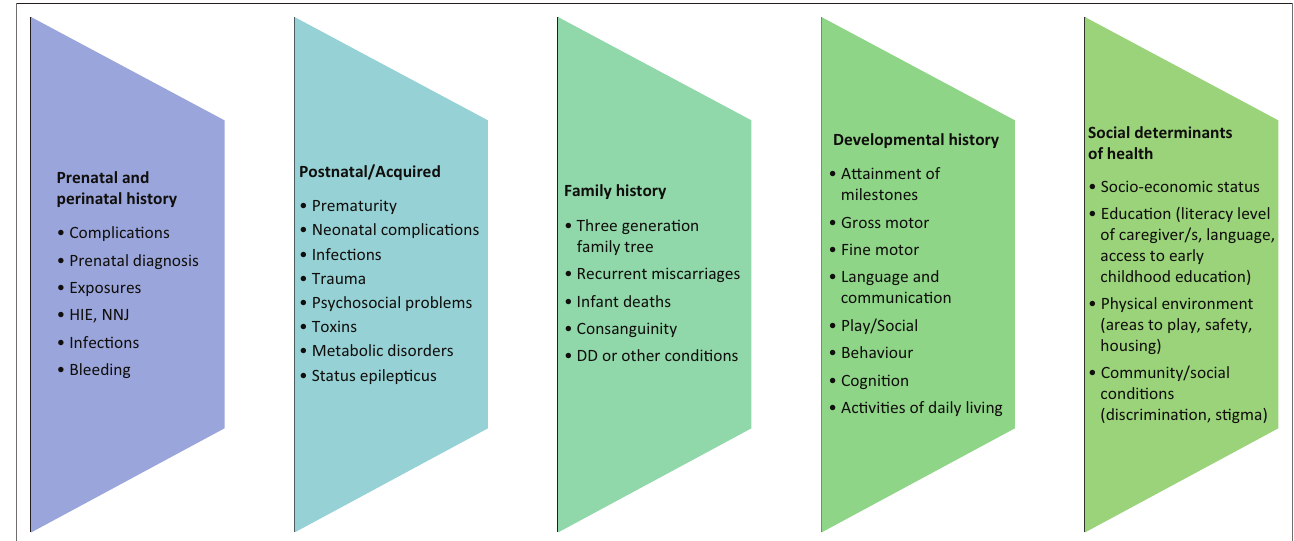
FIGURE 1: Aspects to consider when obtaining a developmental